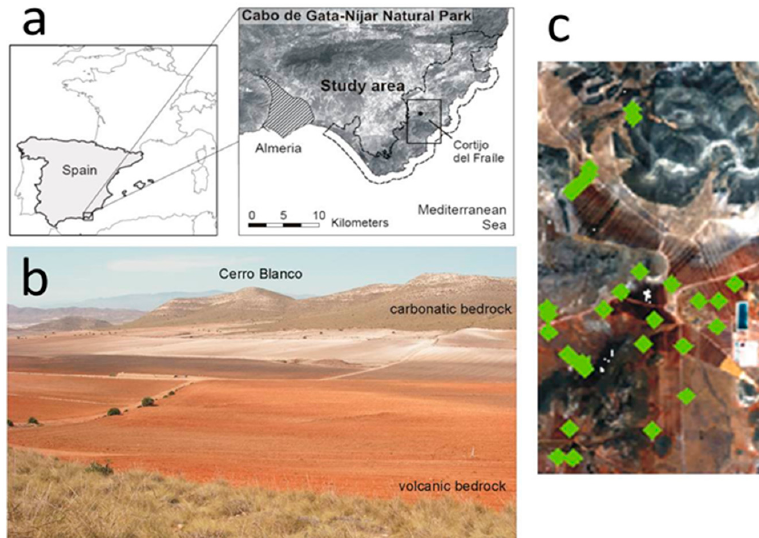
Figure 1. Cabo de Gata-Nijar Natural Park test site (modified from [40]): ( a ) map of Spain with location of HyMap imagery (bold rectangle) and study area Cortijo del Fraile; ( b ) wiew of the volcanic-carbonatic bedrock transition; and ( c ) RGB true-color HyMap imagery with sample points (green dots) and selected study area Cortijo del Fraile.